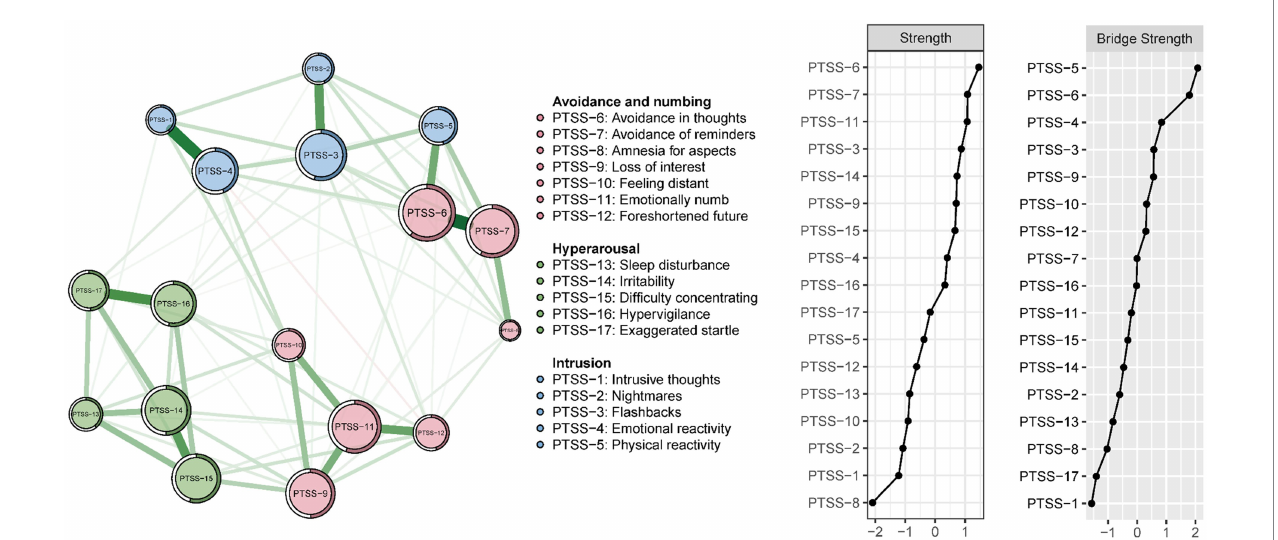
FIGURE 1 Network model of the PCL-C in the whole sample ( N = 10,516) estimated by the Extended Bayesian Information Criterion graphical lasso (EBICglasso) method. The size of each node indicates the relative level of strength. Green edges indicate positive associations; red edges indicate negative associations. The values of strength and bridge strength were transformed into z-scores.